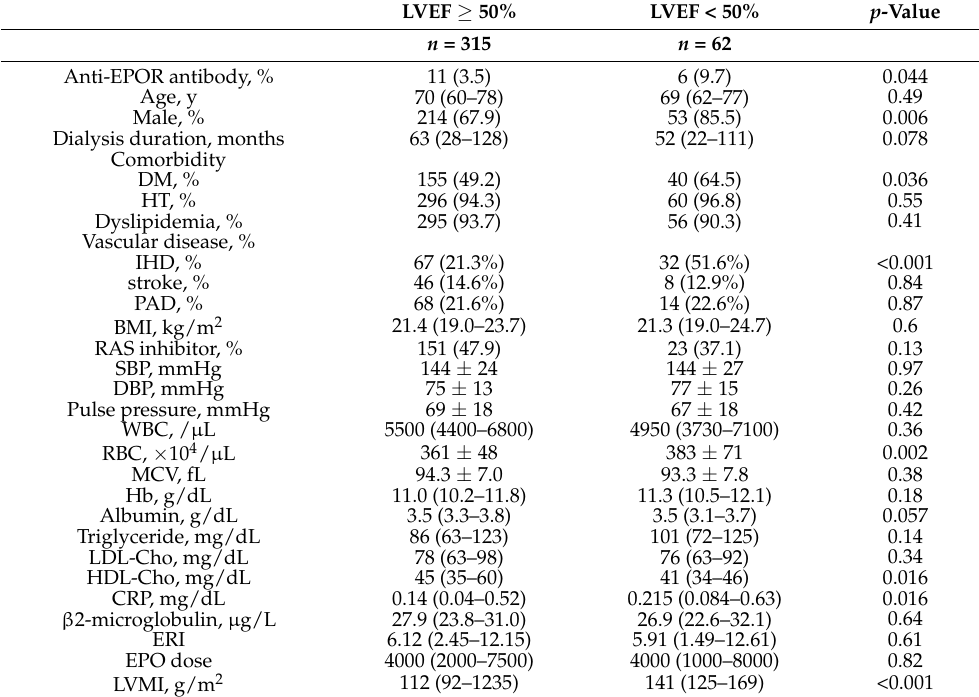
Table 2. Baseline characteristics of patients with and without LVEF < 50%.